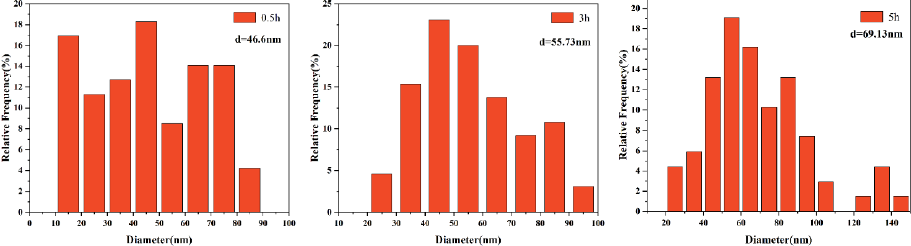
Figure 7. The distribution of TiN precipitates size after different holding time at the austenitizing temperature of 950 °C.